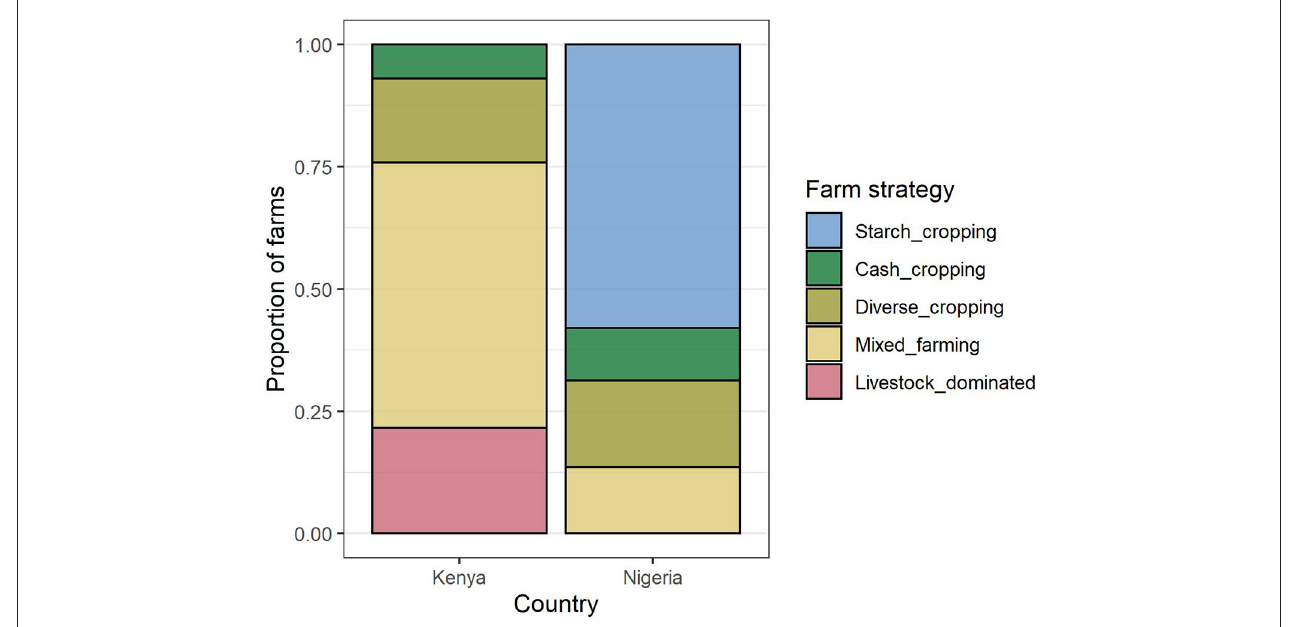
FIGURE 4 | Proportion of farms in each country belonging to each farm FC group, as identified by the hierarchical cluster analysis.